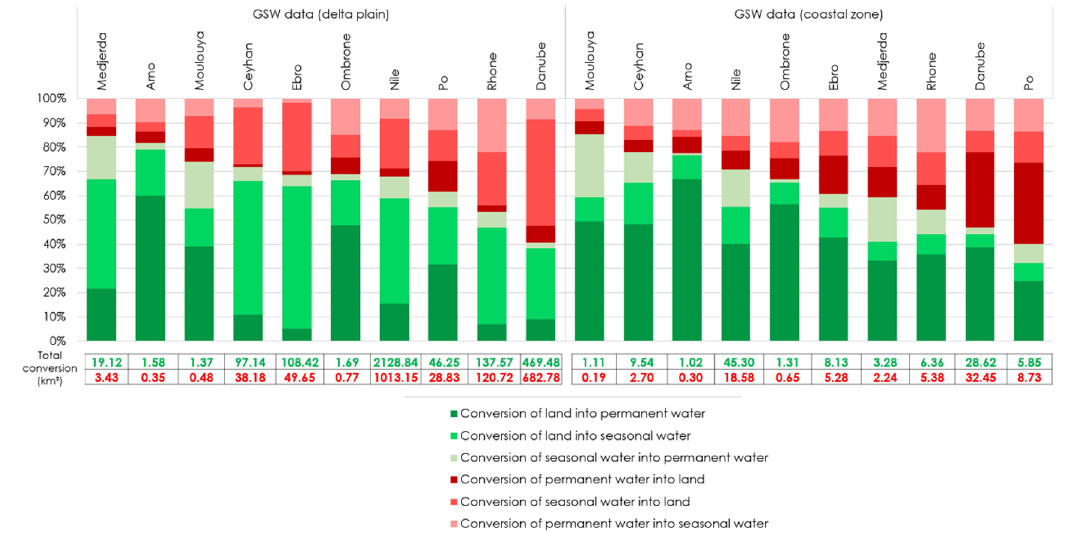
Figure 6. Percentages of various categories of land → water and water → land conversions for the ten delta plains and their coastal zones.